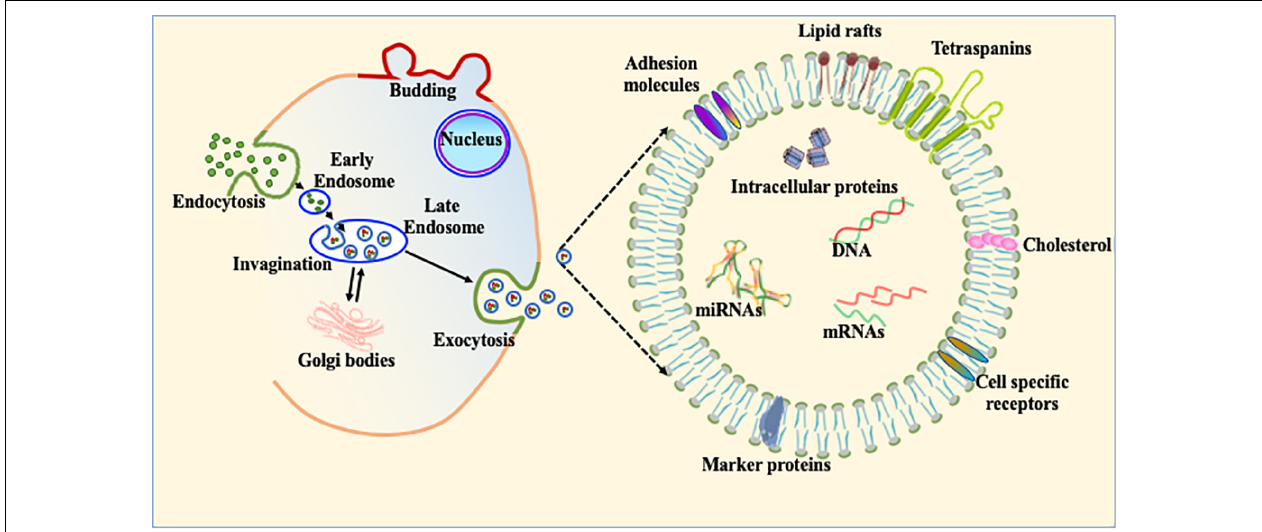
FIGURE 4 | Exosome biogenesis and its constituents. The schematic diagram of exosomal biogenesis. Exosomes are membranous vesicles 30–120 nm in diameter formed by the inward budding of the cellular membrane. This can shed off inward and fuse with early endosomes which become known as late endosomes and multivesicular bodies (MVBs). These nanovesicles carry various cellular components, such as mRNA, microRNA, DNA, and proteins within their bilayer lipid membrane such as Alix, Tsg101, and